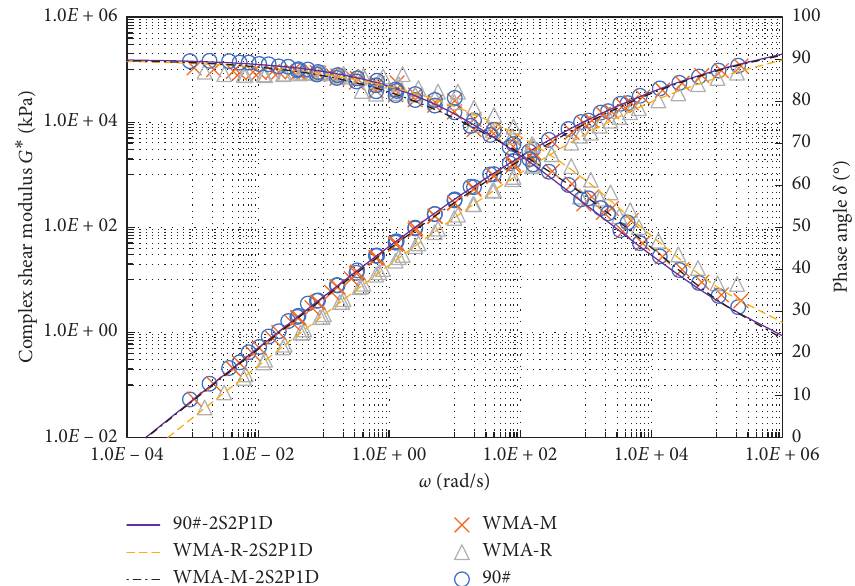
Figure 4: Complex shear modulus and phase angle master curves of three types of virgin asphalt